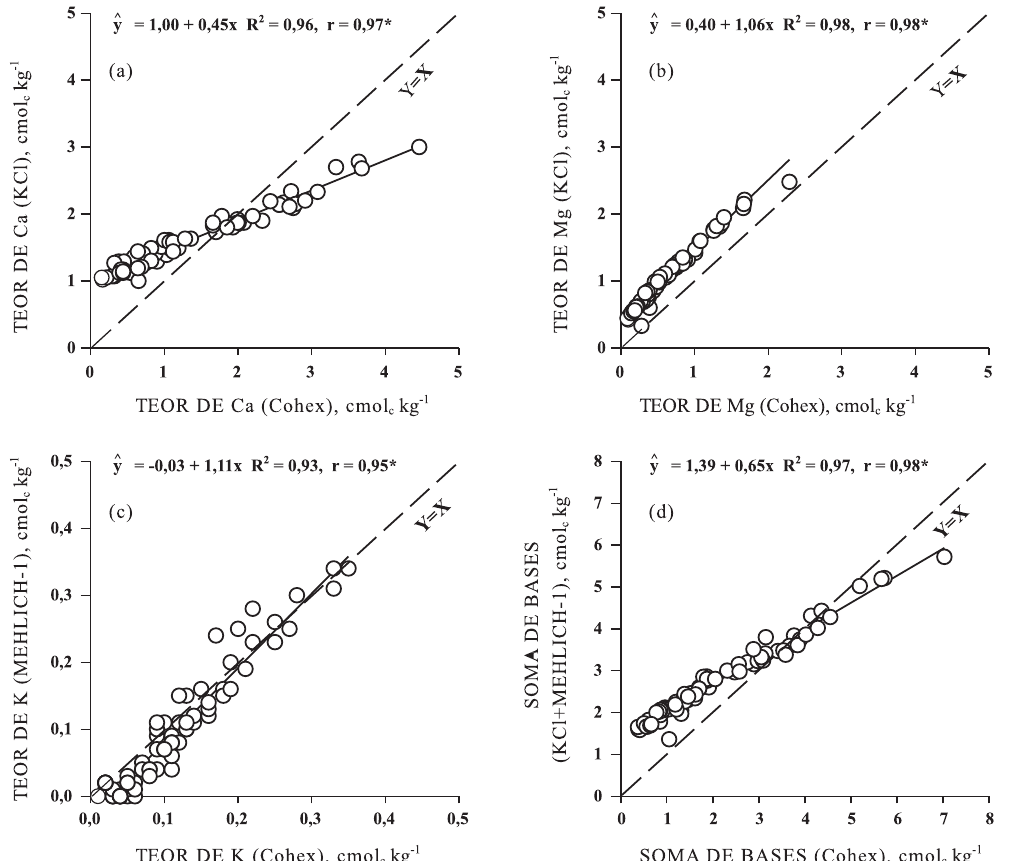
Figura 1. Relação entre valores de cátions e soma de bases obtidos por diferentes métodos em 75 amostras de um Argissolo